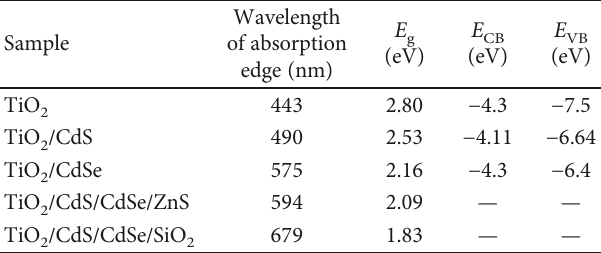
Table 1: The parameters obtained from UV-Vis.